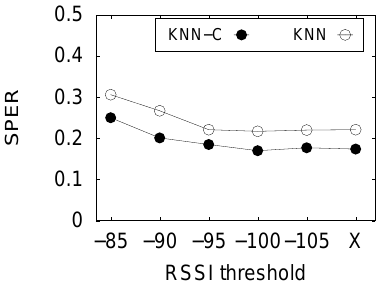
Figure 9. Preliminary study on RSSI value thresholding.